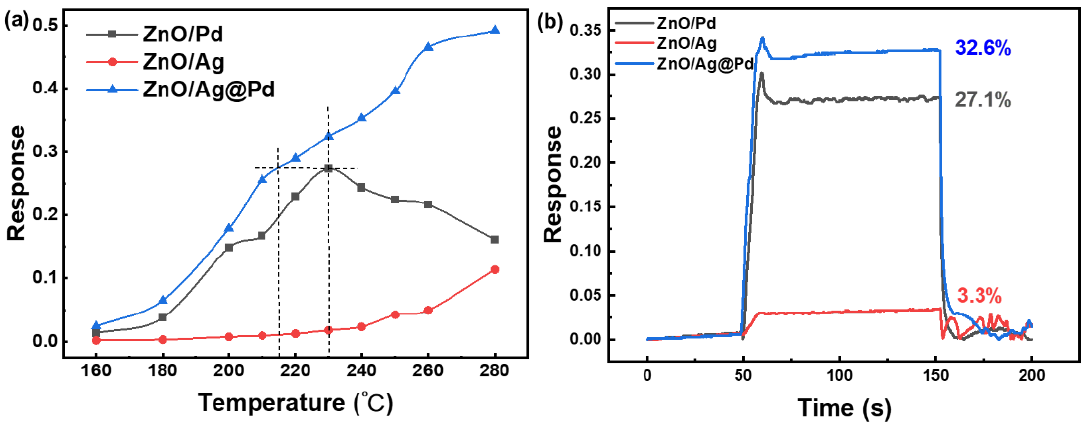
Figure 6. ( a ) Response to 500 ppm CH 4 of ZnO/Pd, ZnO/Ag and ZnO/Ag@Pd at different temperatures. ( b ) Dynamic response curves of ZnO/Pd, ZnO/Ag and ZnO/Ag@Pd to 500 ppm CH 4 at 230 °C.